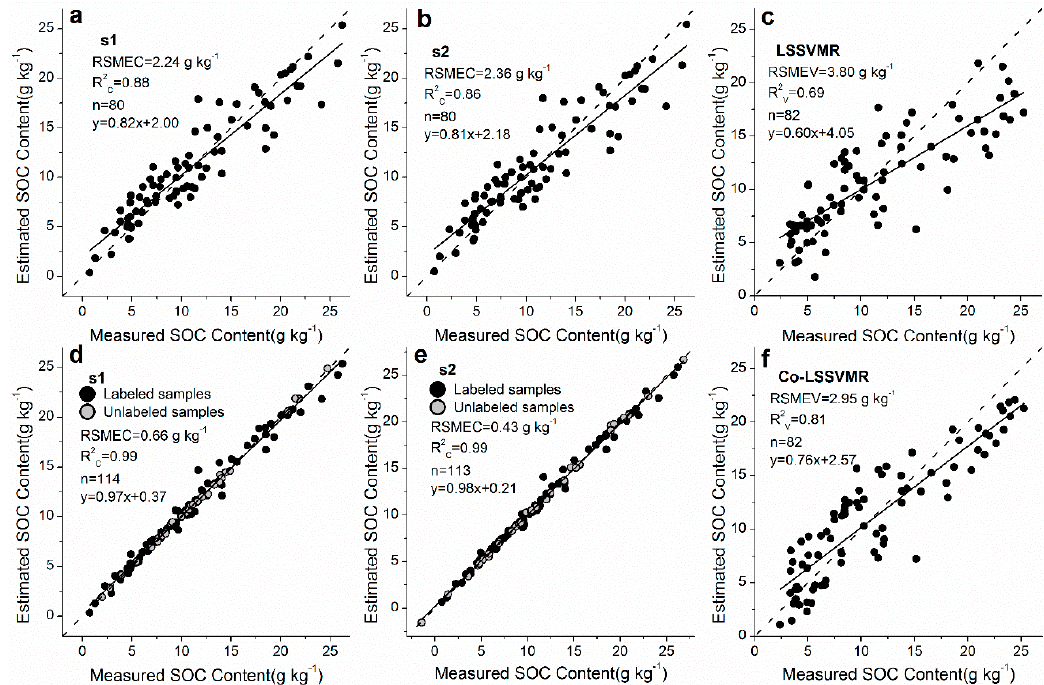
Figure 9. Scatter plots of the estimated versus measured SOC content (g·kg − 1 ) for the calibration dataset obtained by two supervised LSSVMR models: s1 ( a ); and s2 ( b ); and for the validation dataset obtained by LSSVMR trained with 80 labeled samples ( c ); scatter plots of the estimated versus measured SOC content for the calibration dataset obtained by the two refined: models s1 ( d ); and s2 ( e ); and for the validation dataset ( f ) obtained by Co-LSSVMR, where 80 out of 164 labeled samples were labeled samples. The “Measured SOC content” for each unlabeled sample in ( d , e ) is the value labeled by the other regressor. The solid line is the regression line between estimated and measured values, and the dashed line is the 1:1 line.